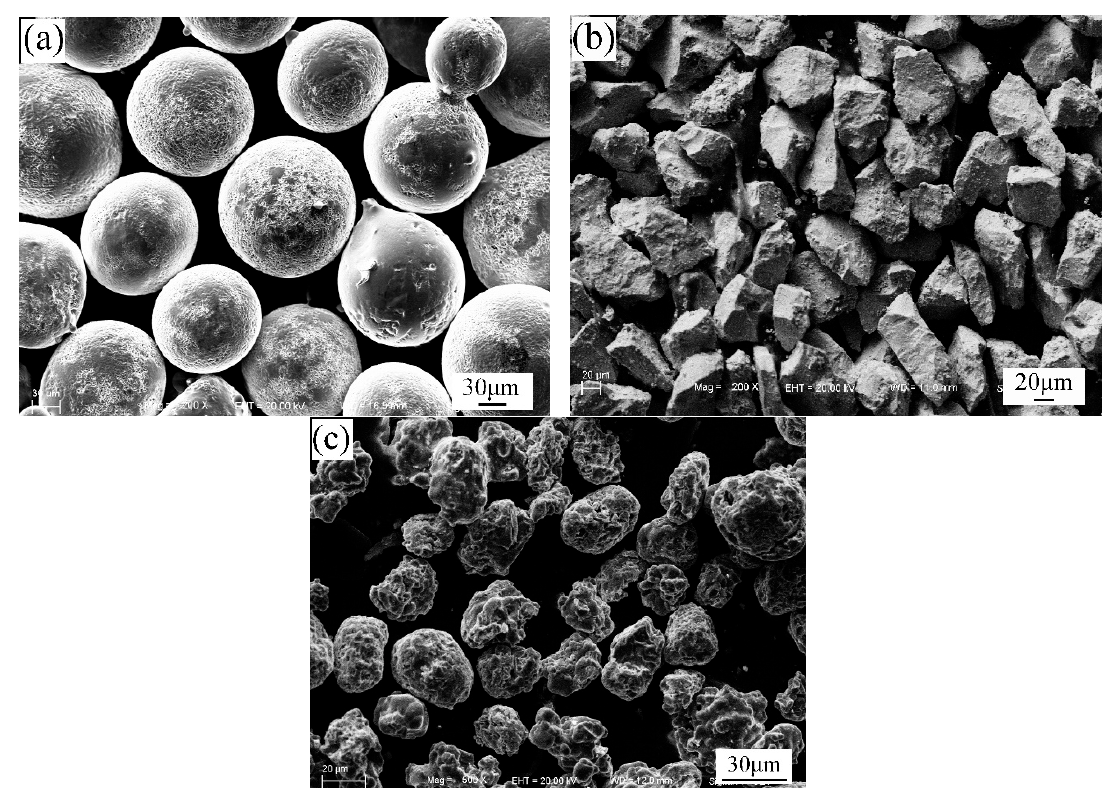
Figure 1. Morphologies of the raw materials in SEM ( a ) NiCrBSi, ( b ) Nb, and ( c ) NiCr-Cr 3 C 2 . Table 1. The chemical compositions of the raw materials (wt.%).